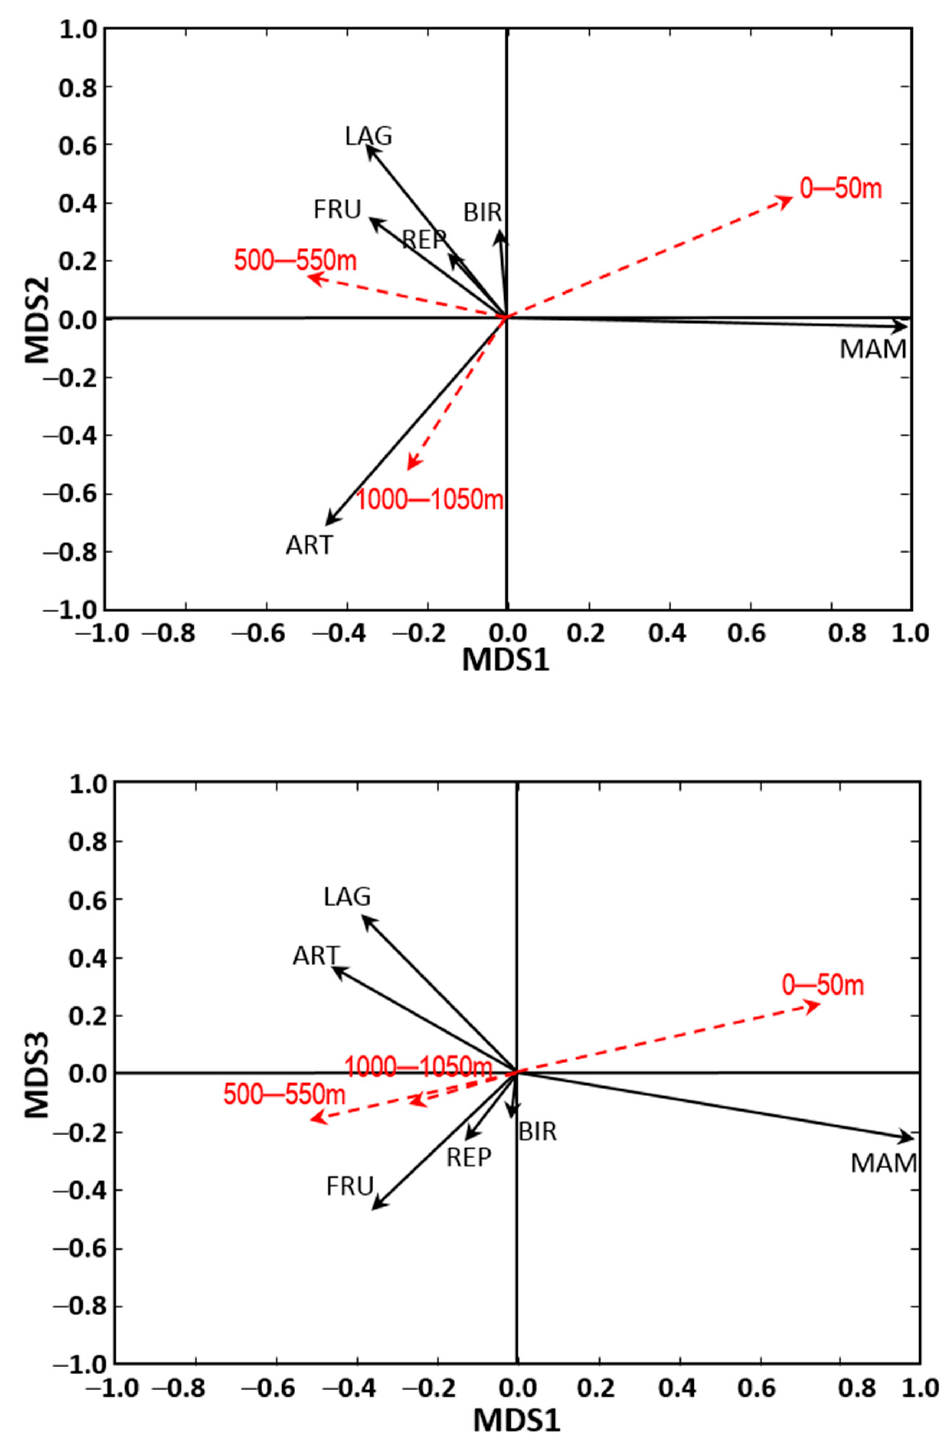
Figure 1. Three-dimensional ordination (MDS) of general trends in carnivore diet. The influence of food resources in terms of percentage of fresh biomass (PB) is represented by arrows of length and direction obtained from their correlation with the axes. To assist the graphical interpretation of results, the figures include dotted red arrows representing the directions of the β coefficients of MANOVA for the three distances, with a module equivalent to β multiplied by 10 to clarify presentation. PB Abbreviations: MAM, small mammals; LAG, lagomorphs; FRU, fruit and seeds; ART, arthropods; BIR, birds; REP, reptiles.